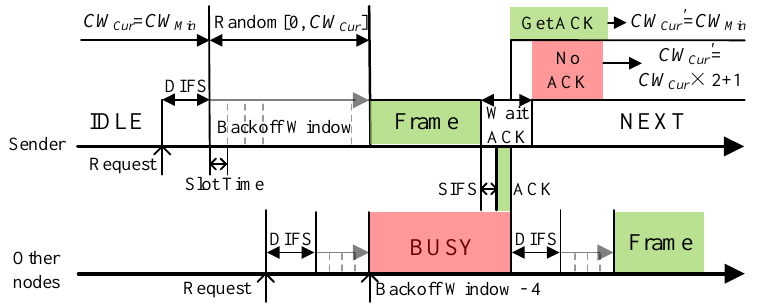
Figure 3. The contention-based MAC protocol process of the WAVE standard. Predictably, the value of CW is crucial in the access process. When the vehicle density is high, a small CW will cause many data collisions. However, too large a CW will lead to increased communication delay. In WAVE, the binary exponential backoff algorithm is used to adjust the CW. The initial value of CW is CW Min . After each transmission failure or no confirmation message (ACK) is received, the CW value is increased to CW Cur × 2 + 1 until it reaches CW Max . And CW will be reset to CW Min after successful transmission. The ACK message is sent by the receiver after receiving the packet and passing the short interframe space (SIFS)